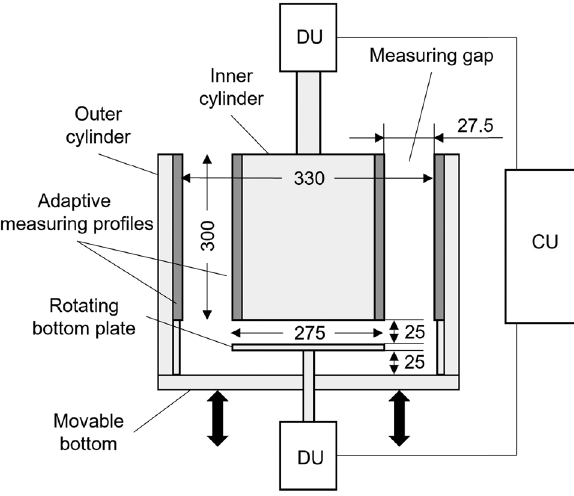
Figure 1: Schematic diagram of the ACCR with corresponding dimensions ( in mm ) ; DU = drive unit and CU = control